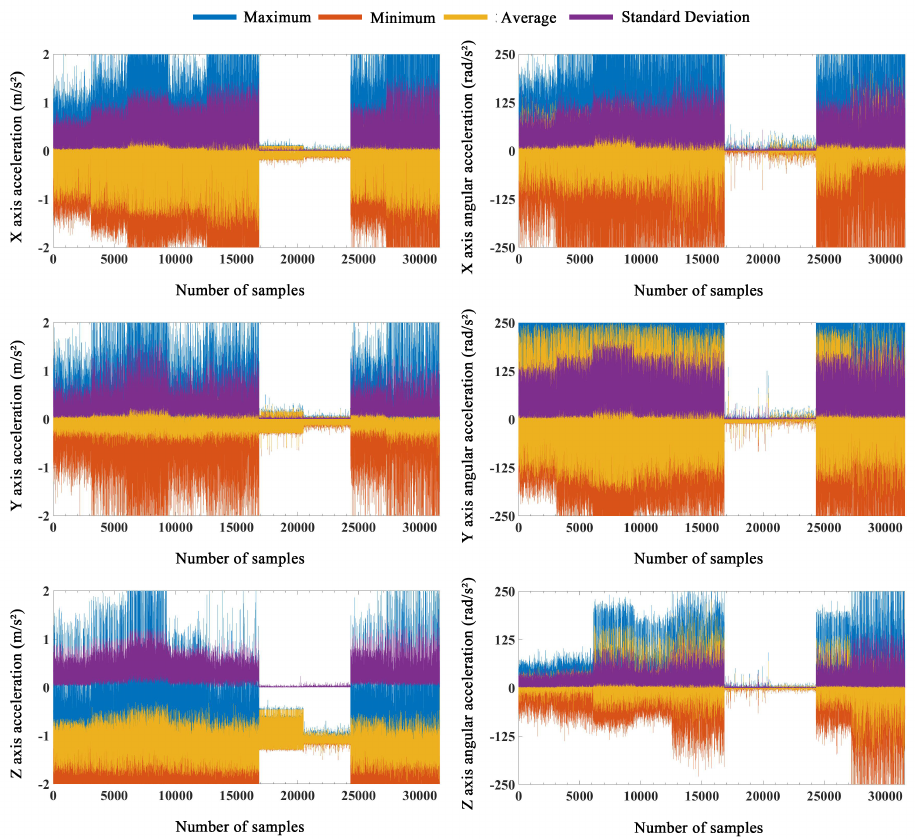
Figure 4. Time domain analysis for the 200-ms time window data (each locomotion mode included approximately 3500 samples arranged from left to right according the order in Figure